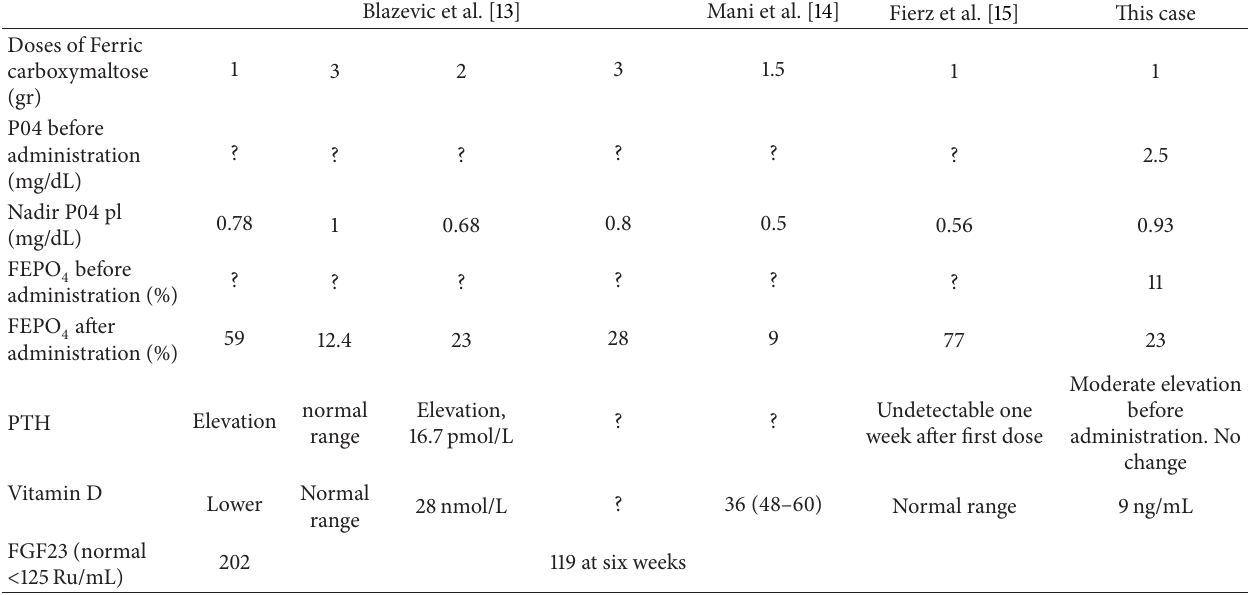
Table 2: Biological parameters of patients reported in the